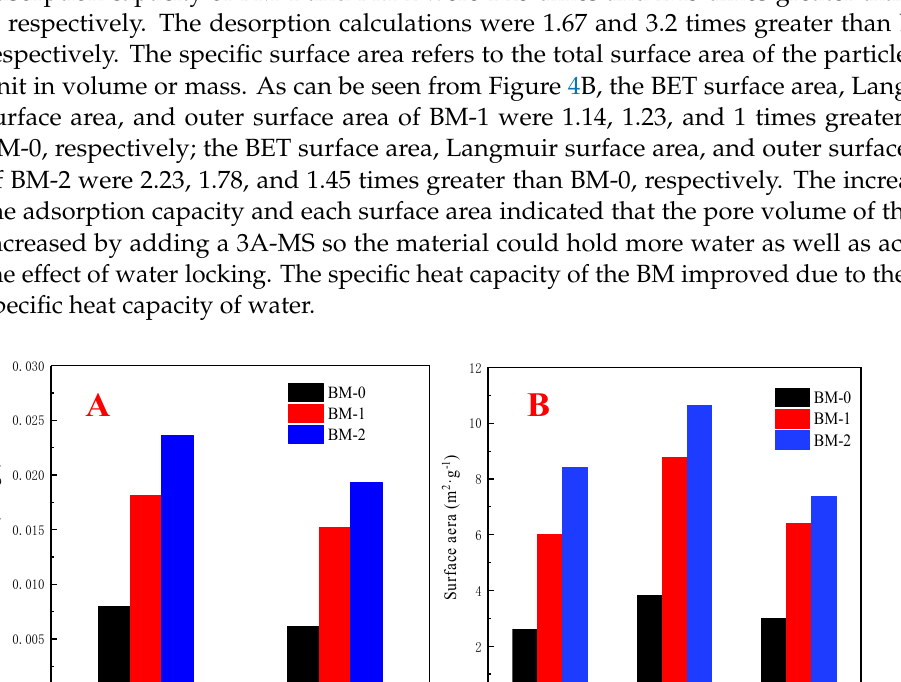
Figure 3. SWCCs and relative thermal properties. ( A ) Soil water characteristic curve; ( B ) Specific heat capacity; ( C ) Thermal conductivity; ( D ) Thermal diffusivity. ( A ) was obtained by data fitting; ( B – D ) were calculated.